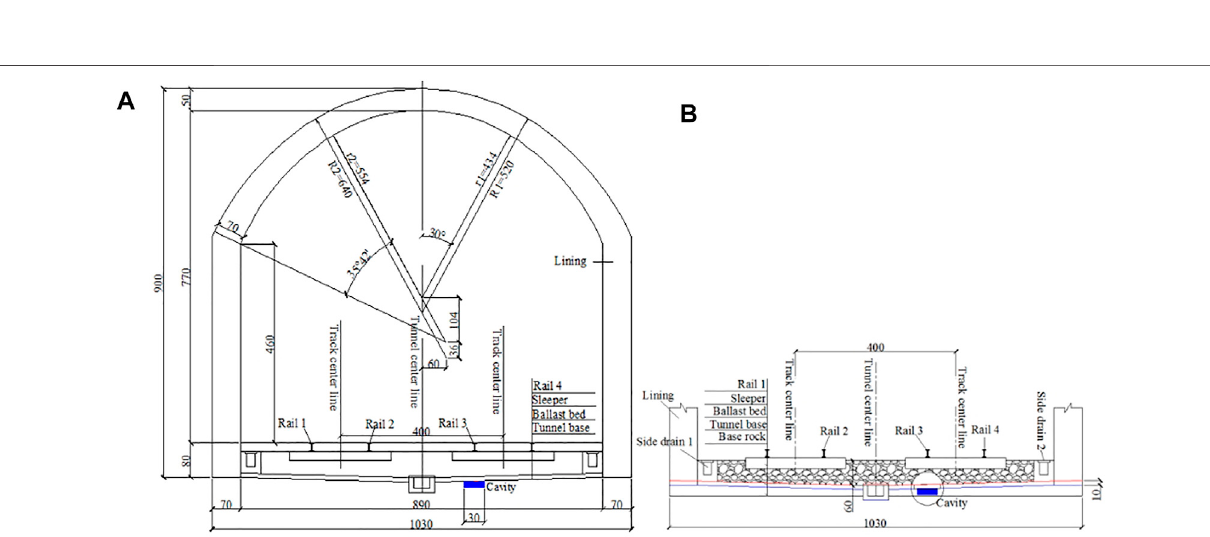
FIGURE 2 | Section diagram of the tunnel with base disease. (A) tunnel section; (B) bottom structure.